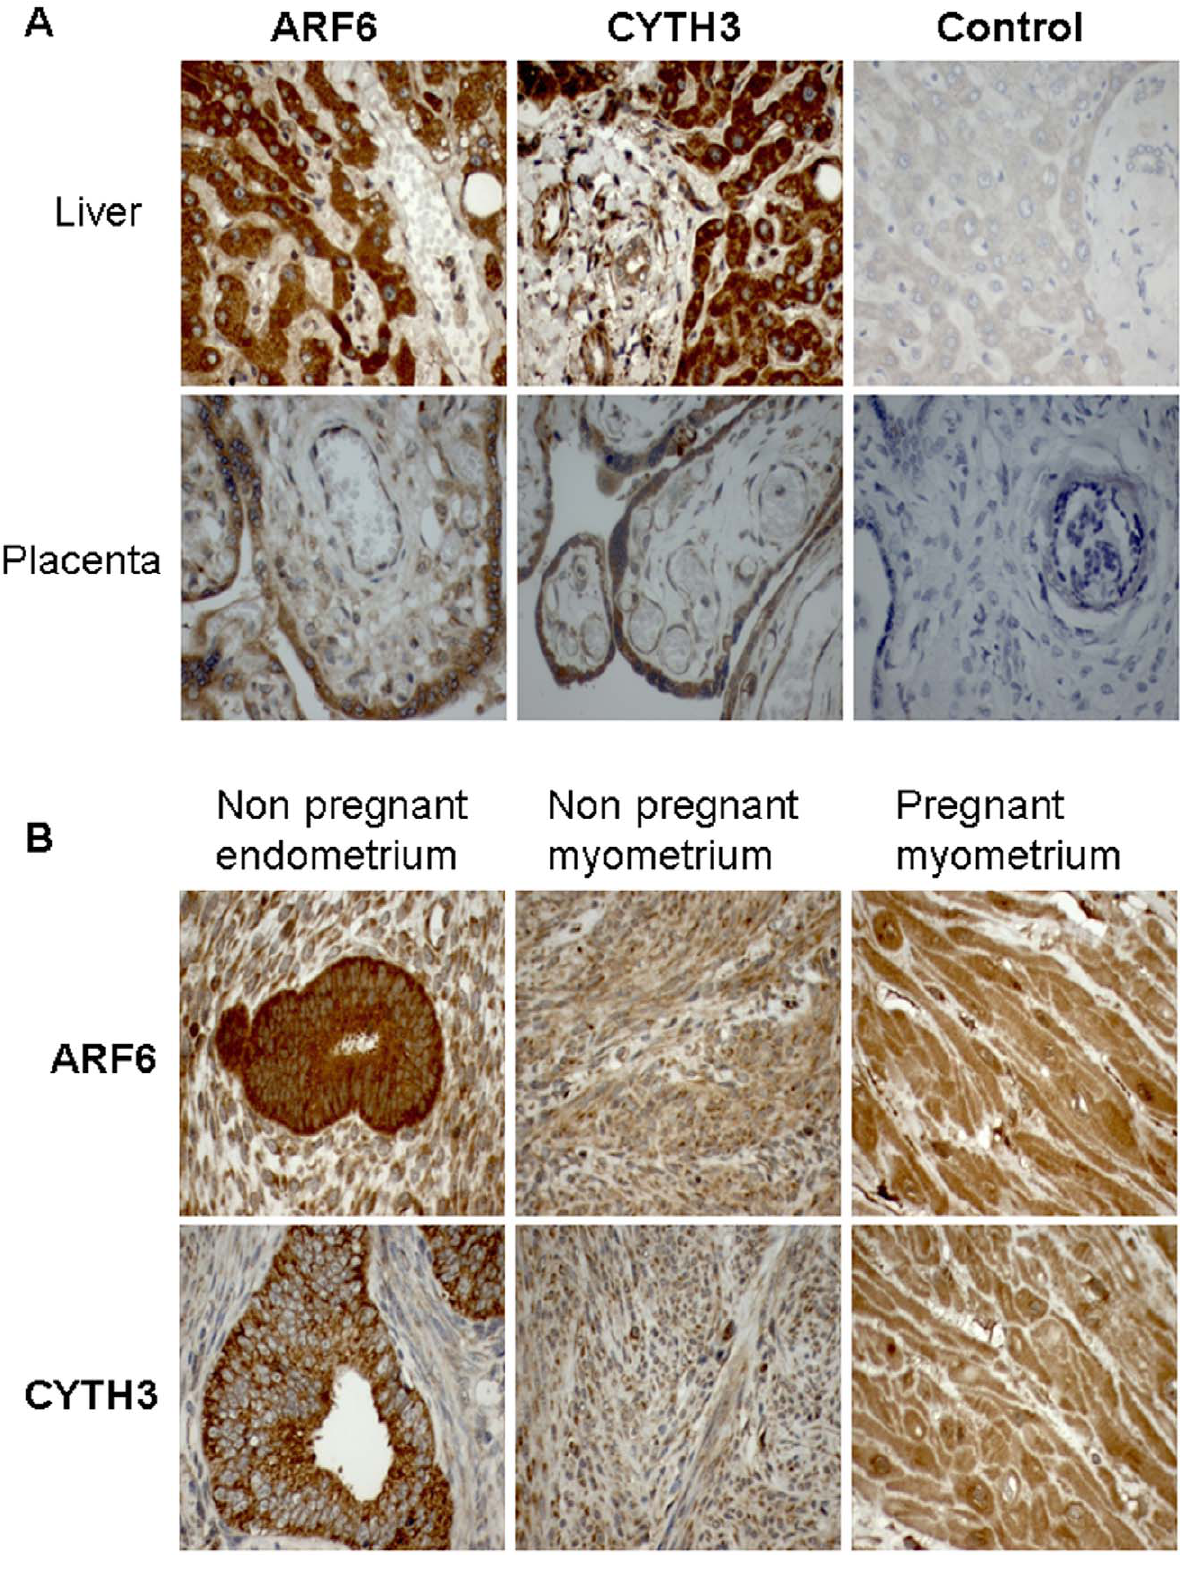
Figure 2. Immunohistochemical localization of ARF6 and CYTH3 in human uterine tissue sections. A. Sections of human placenta and liver show clear ARF6 and CYTH3 immunostaining. Negative controls on the right hand side were obtained with pre-immune serum. B. ARF6 and CYTH3 showing dense intracellular staining in non-pregnant endometrial glands and uniform intracellular staining pattern in both non-pregnant and pregnant myometrial cells. The images were taken at 40 6 magnification.